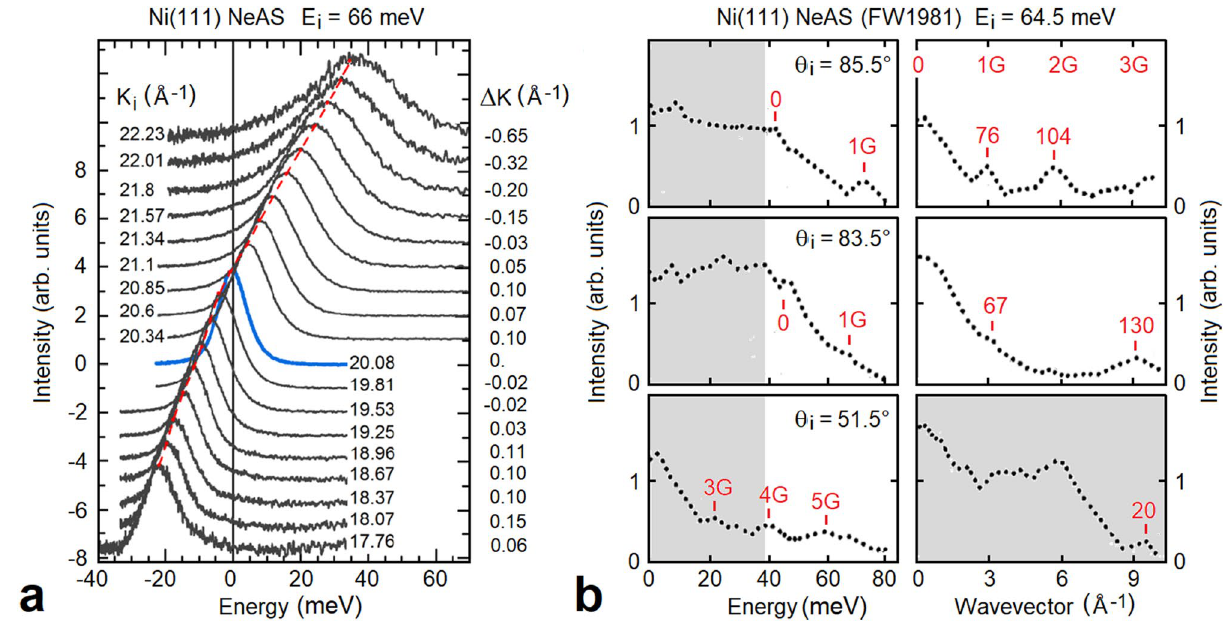
Figure 1. ( a ) NeAS time-of-flight (TOF) spectra, measured with an incident energy of 66 meV along the Ŵ M direction of the Ni(111) surface at a temperature of 400 K, plotted as a function of the energy transfer for different parallel incident wavevectors K i and a constant scattering angle of 105.4 ◦ . The incident angles 1 ) to 52.7 o 1 ) (specular condition 22.23 Å 17.76 Å 8 9 vary at intervals of 1 ◦ from 52.7 o − − ◦ ( K i = ◦ ( K i = − + corresponds to the blue curve). The parallel wavevector transfer (cid:31) K corresponding to the maxima (broken red curve) of the inelastic peaks, show that the corresponding excitations occur at comparatively small wavevectors, compatible with the assignement to SASP. ( b ) Early inelastic NeAS spectra from Ni(111) in the Ŵ M direction by B. Feuerbacher and Willis 20 as privately communicated to Bortolani and reproduced in Ref. 29 in a preliminary theoretical study. The spectra are plotted vs. energy transfer (left) and wavevector transfer (right), for an incident energy of 65.4 meV, a fixed scattering angle of 135 ◦ and the surface at room temperature (grey areas: bulk phonon region). The features assigned to SASP fall at about integer multiples of the reciprocal-lattice G vector (marked in left panel), also with energies (marked in right panel) well outside the phonon spectrum. The higher SASP energies can be observed on the annihilation side where noise is smaller; errors are estimated to be 1 for wavevectors at 100 meV and 0.1Å 2meV for − ± ±